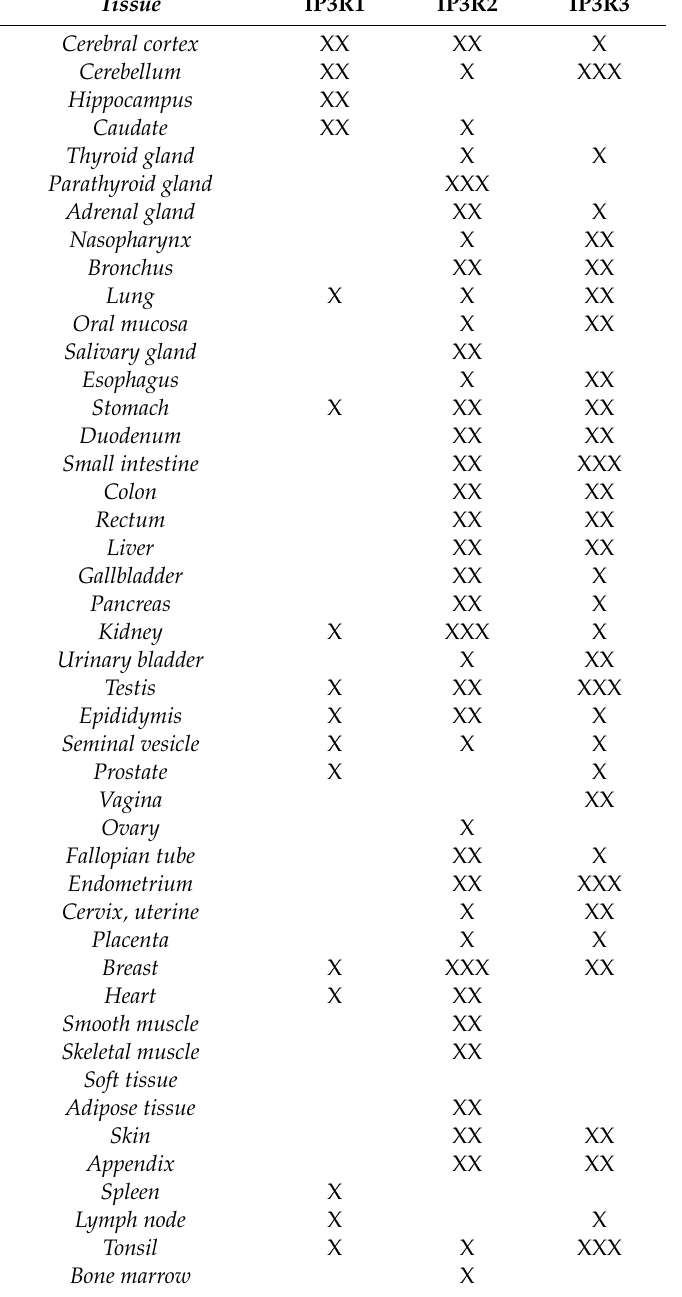
Table 1. Protein expression levels of IP3Rs in di ff erent human tissues and